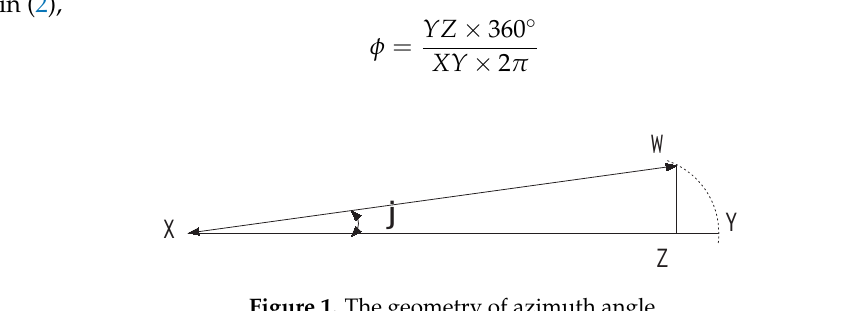
Figure 1. The geometry of azimuth